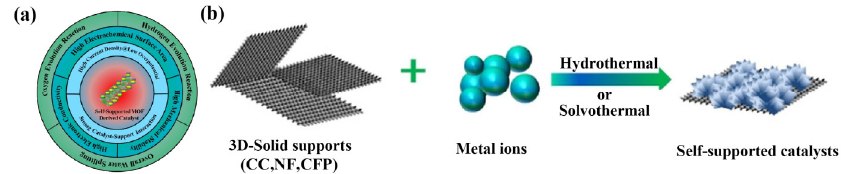
Figure 9. ( a ) Illustration of the interfacial engineering of heterogeneous catalysts. ( b ) Synthesis of self-supported catalyst systems for the electrocatalytic water splitting. Reproduced with permission self-supported catalyst systems for the electrocatalytic water spliing. Reproduced with permission from Ref. [97]. Copyright 2020, Wiley-VCH. from Ref. [97]. Copyright 2020,